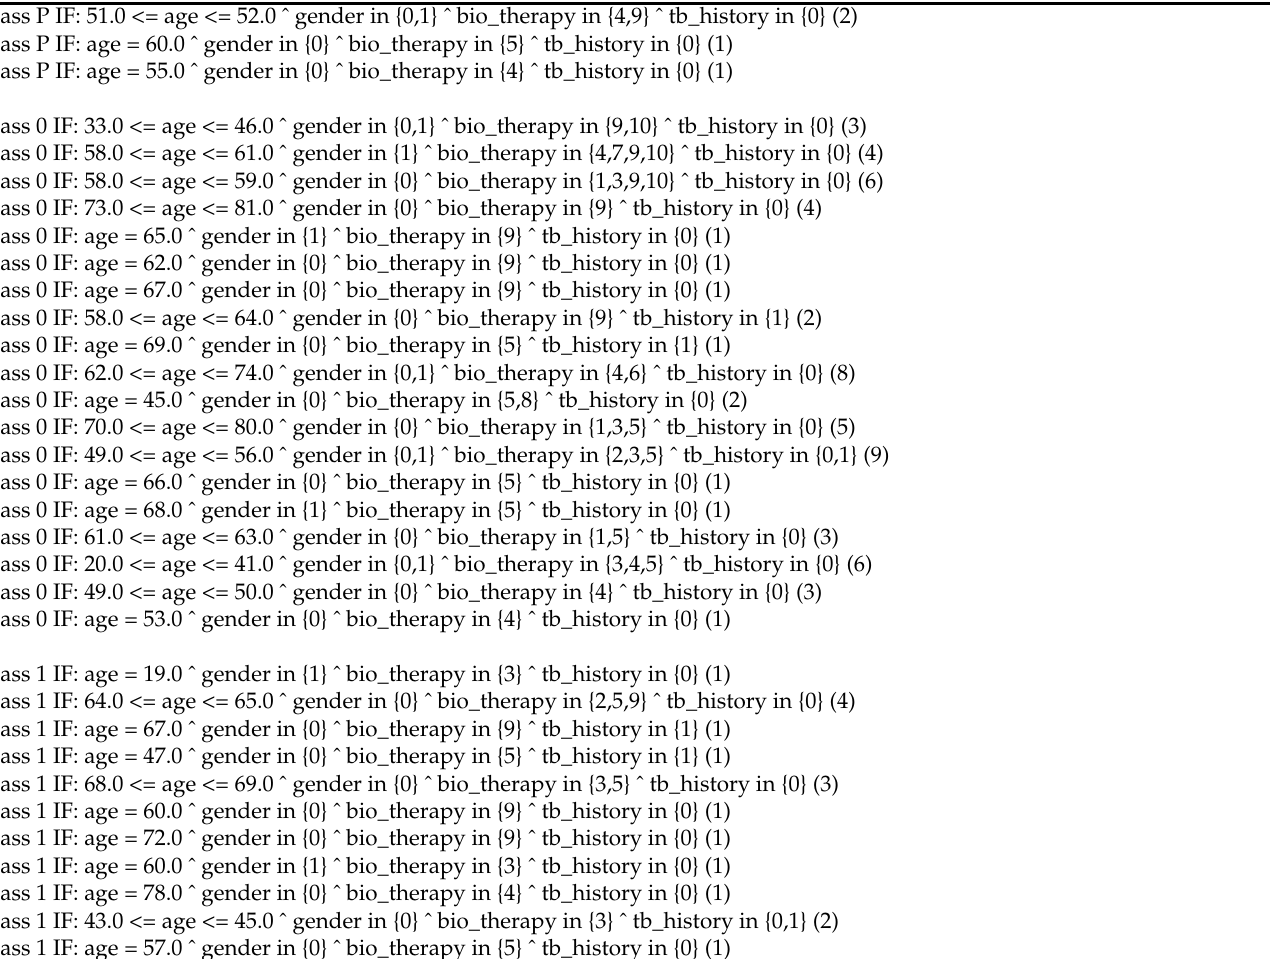
Table 13. Model of rules for the positivation of QuantiFERON-TB Gold Test with attribute selection, obtained with the NNGE